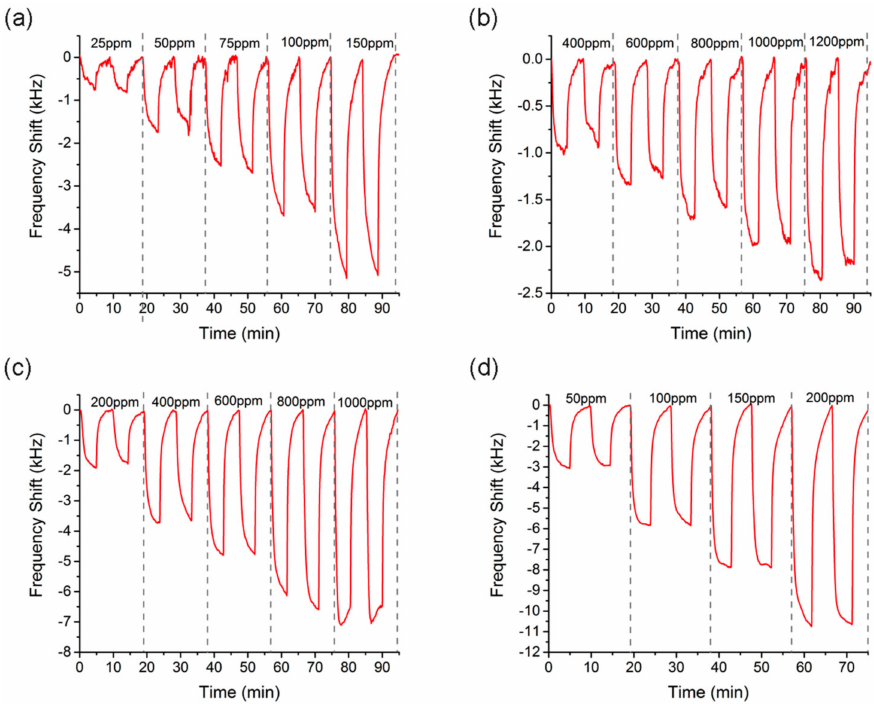
Figure 4. Real time response of the Love-wave sensor for different concentrations of the solvents: ( a ) butanol, ( b ) isopropanol, ( c ) toluene and ( d )